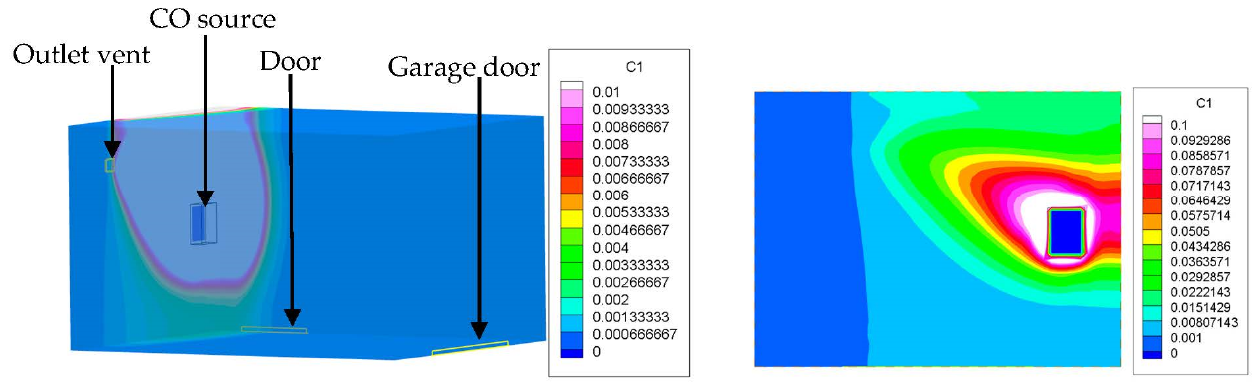
Atmosphere 2021 , 12 , x FOR PEER REVIEW Figure 5. CO distribution in the garage—case 2 (concentration of CO in kg/kg). Figure 5. CO distribution in the garage—case 2 (concentration of CO in kg/kg).